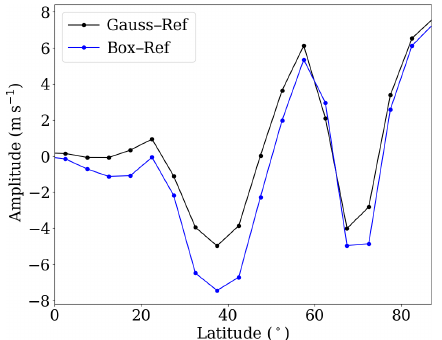
Figure 8. SPW 1 amplitude as the difference between the H3 sim- ulation and the reference simulation (blue line) and the Gauss dis- tribution and the reference simulation (black line) at 35km for the last 30d extracted from the zonal